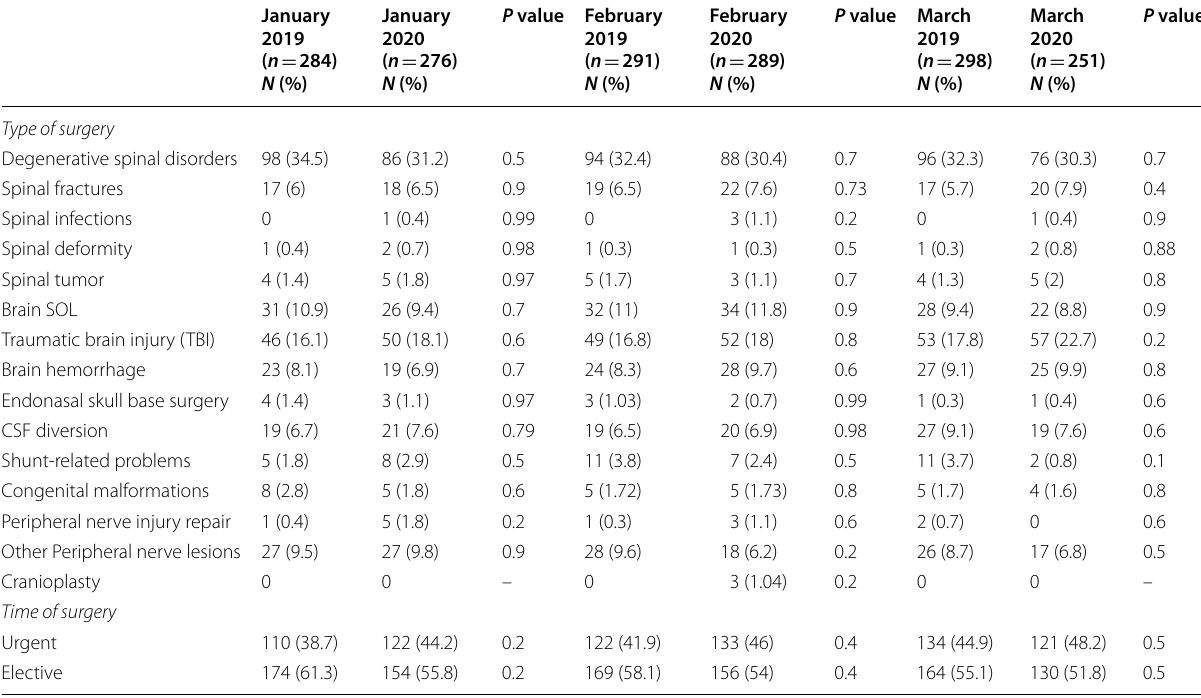
SOL space occupying